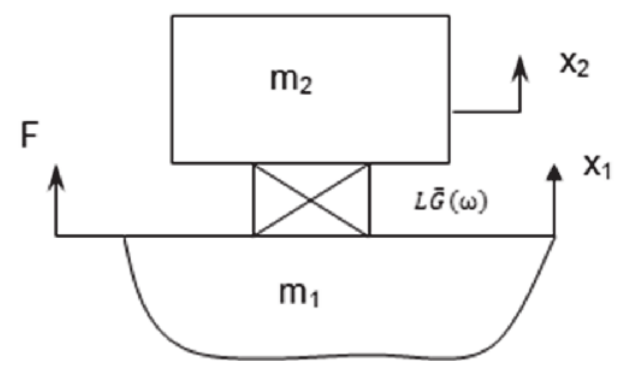
Structural System (m1) fixed to an ADV with hysteretic or viscoelastic